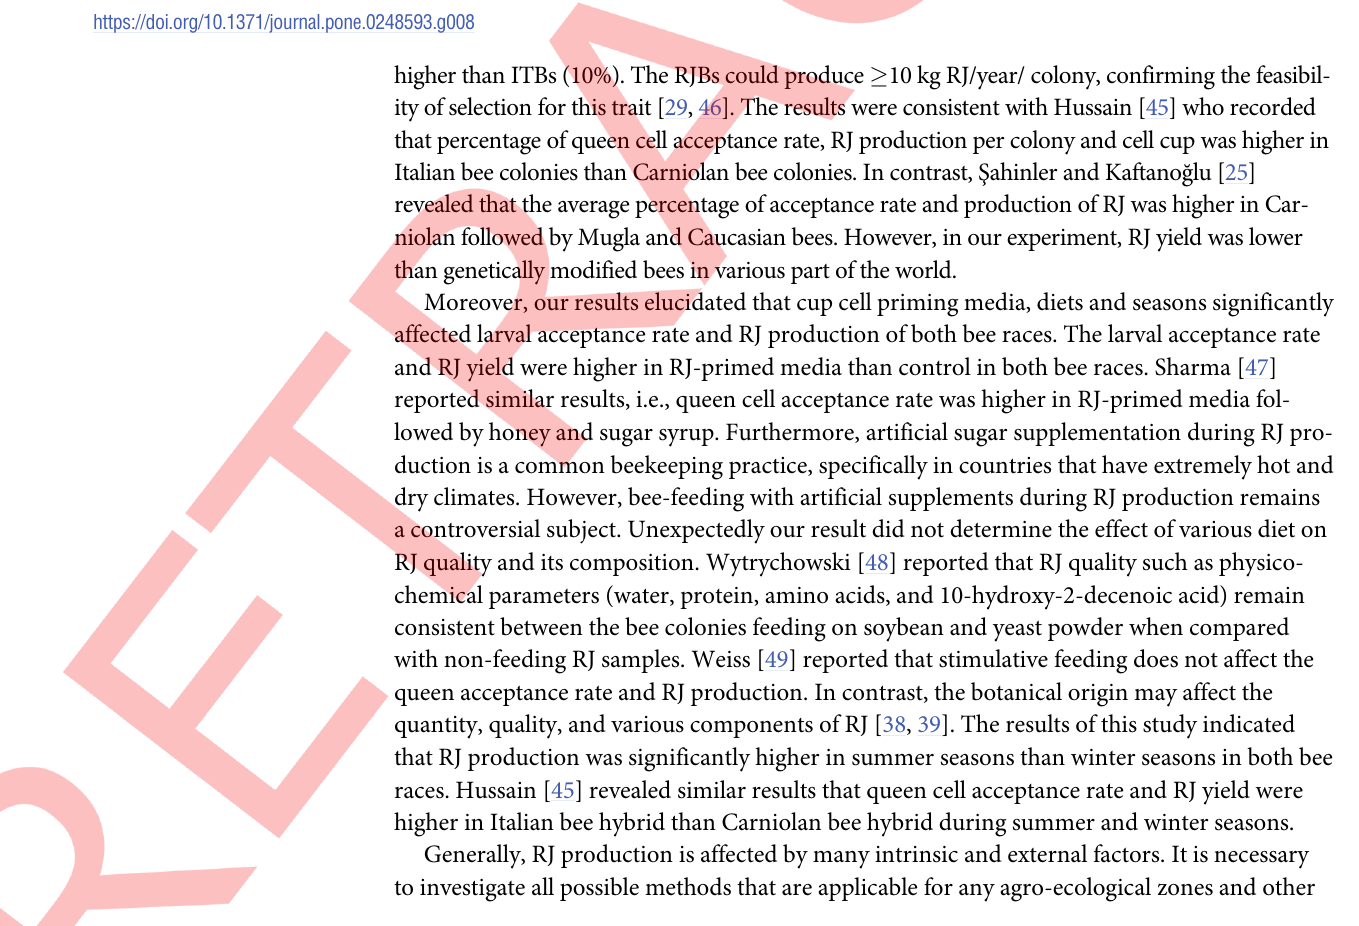
Fig 8. The mean weight of royal jelly (shows as mean ± SE) production between Italian and Carniolan colonies during summer and winter. (a) RJ production per colonies in grams after 72 hours of harvesting, (b) RJ production per cell cup in (mg) between both bee stocks. “ a, b, c ” different letter represents significant mean differences (Student’s t -test, p <